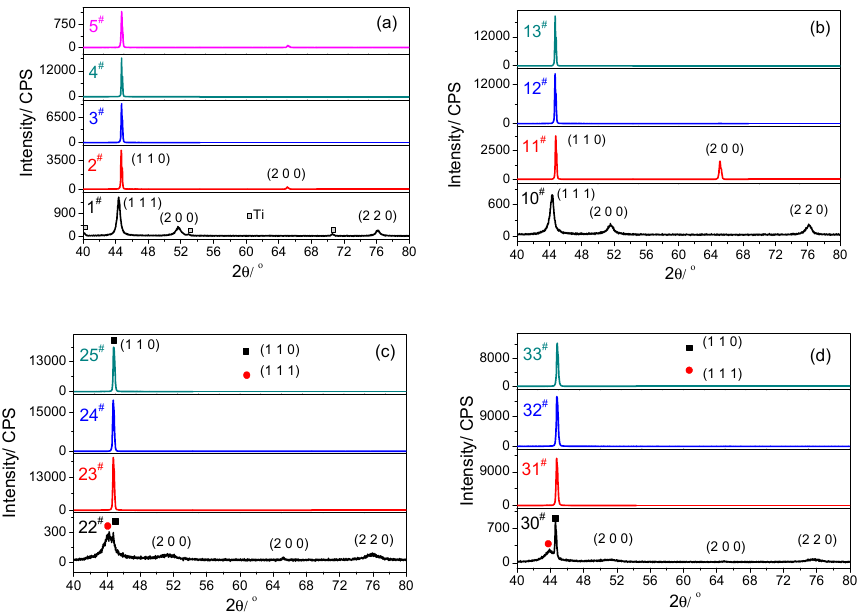
Figure 10. XRD patterns of Fe–Ni alloy foils electrodeposited from chloride baths that contained different Ni 2+ ion concentrations of ( a ) 0.1 M, for 1 # to 5 # samples, ( b ) 0.3 M, for 10 # to 13 # samples, ( c ) 0.6 M, for 22 # to 25 # samples, and ( d ) 0.8 M, for 31 # to 33 # samples.